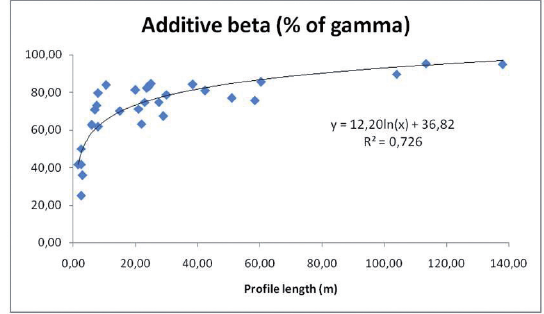
Figure 4. Logarithmic relation between the additive beta compo- nent of species richness and vegetated profile length, a measure of stability in foredunes.